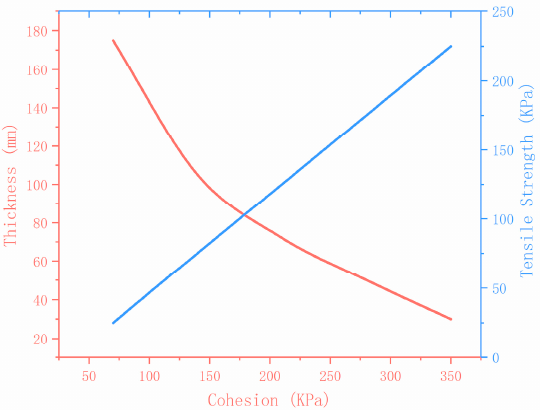
Figure 7. Analysis of the influence of cohesive force on vermiculite woven bags.